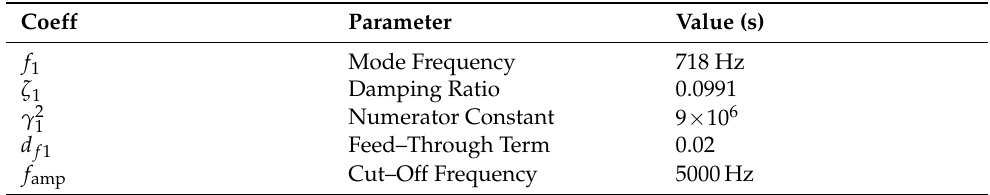
Table 5. Identified model